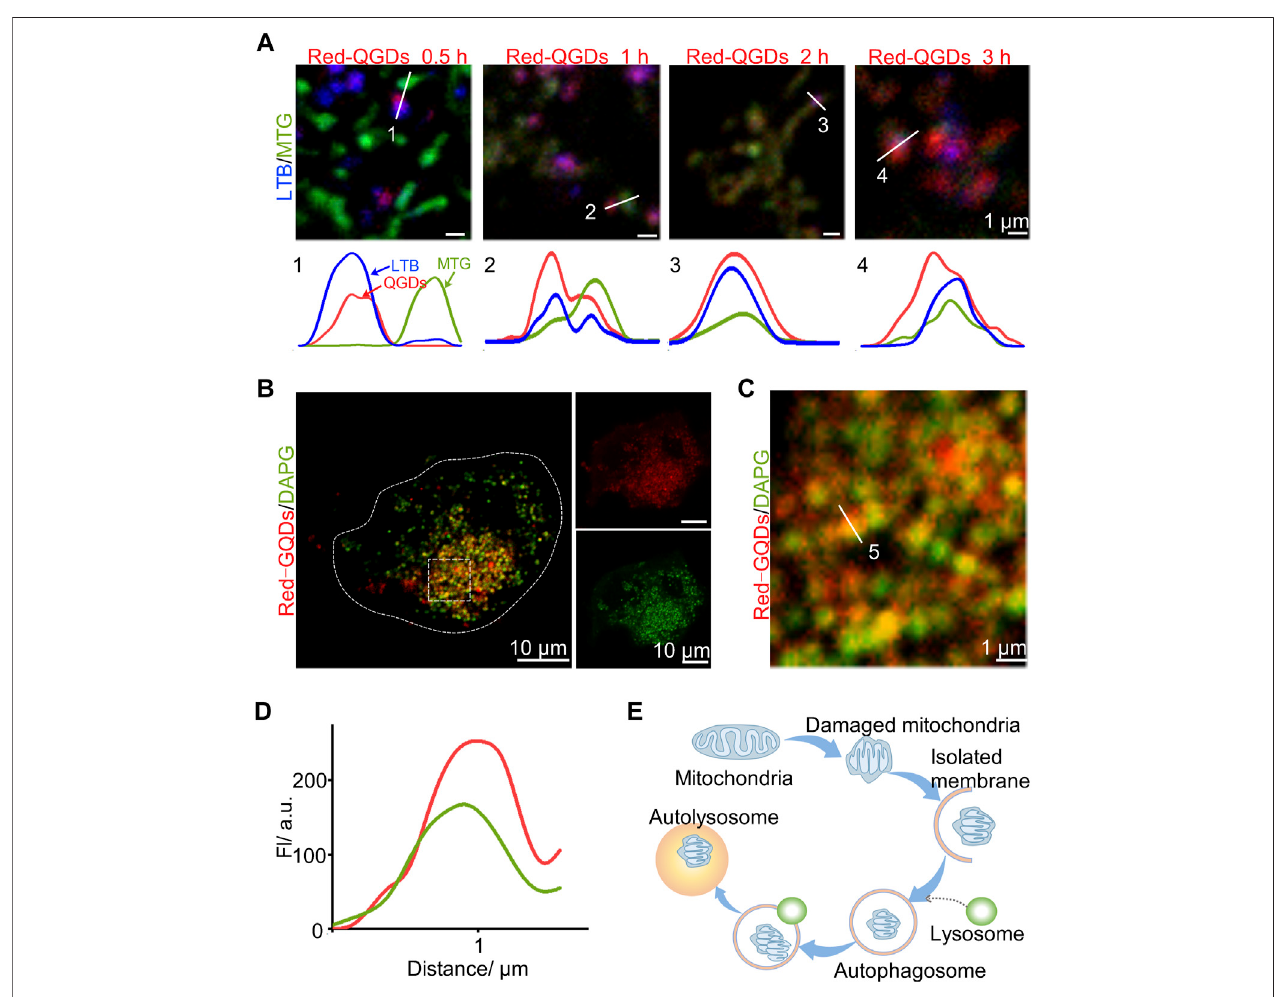
FIGURE3| Red-GQDsoflowerconcentrationassociatedwithautophagosomes. (A) Co-localizationofLTB,MTG,andRed-GQDs(25 μ g/ml)for0.5,1,2,and3 h in HeLa cells was observed by LSM980. (B) HeLa cells were co-stained with Red-GQDs (25 μ g/ml, 1 h) and DAPGreen. DAPGreen: λ ex = 488 nm. (C) Fluorescence image of the enlarged region indicated by the white rectangle in (B) . (D) White solid lines labeled 5 in (C) indicate fl uorescence intensity. (E) Schematic diagram of the in fl uence of Red-GQDs on